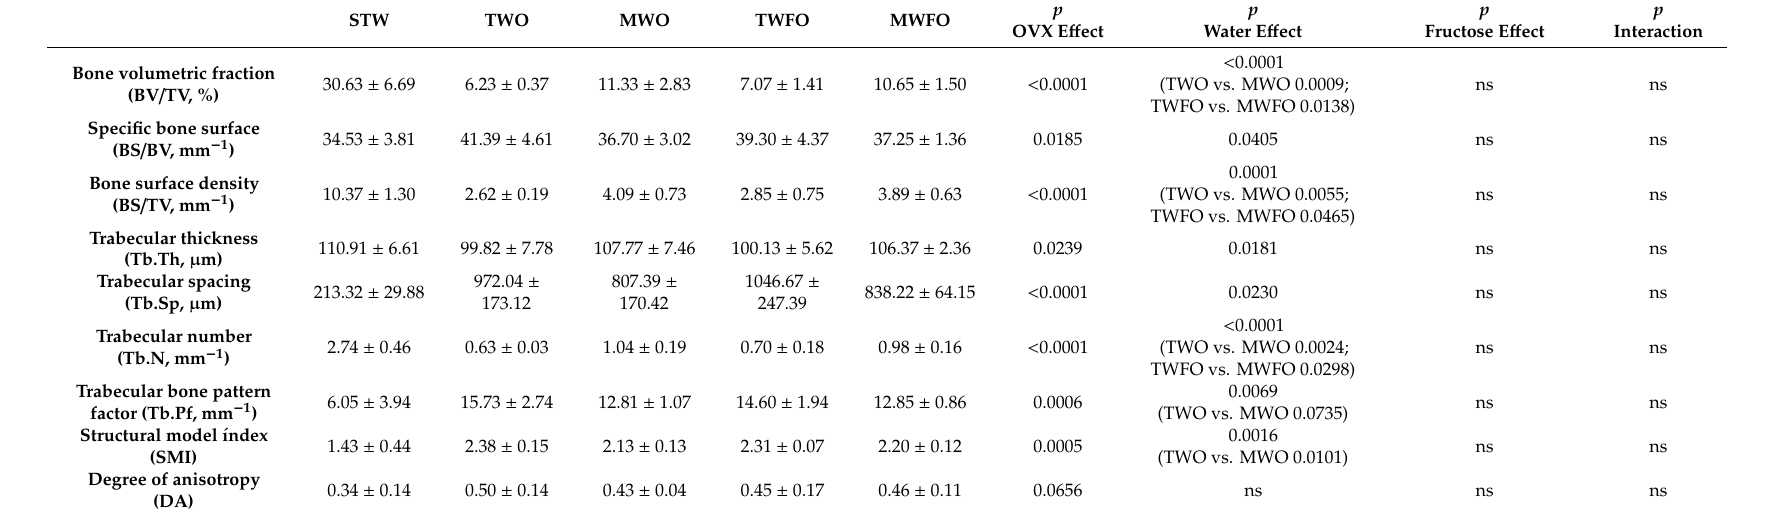
Table 1. Cancellous bone region (rat distal femur) evaluation of microstructural properties by microcomputed tomography. STW TWO MWO TWFO MWFO